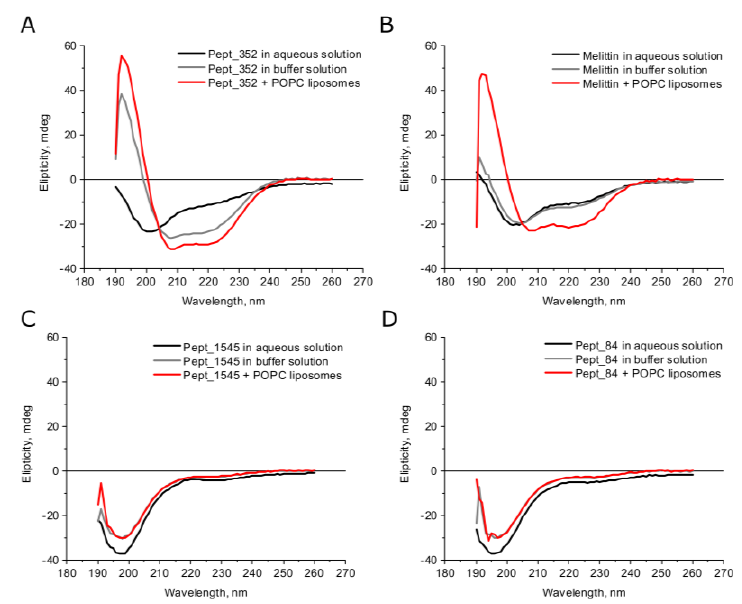
Figure 1. Secondary structure analysis of peptides under di ff erent conditions by CD spectroscopy.